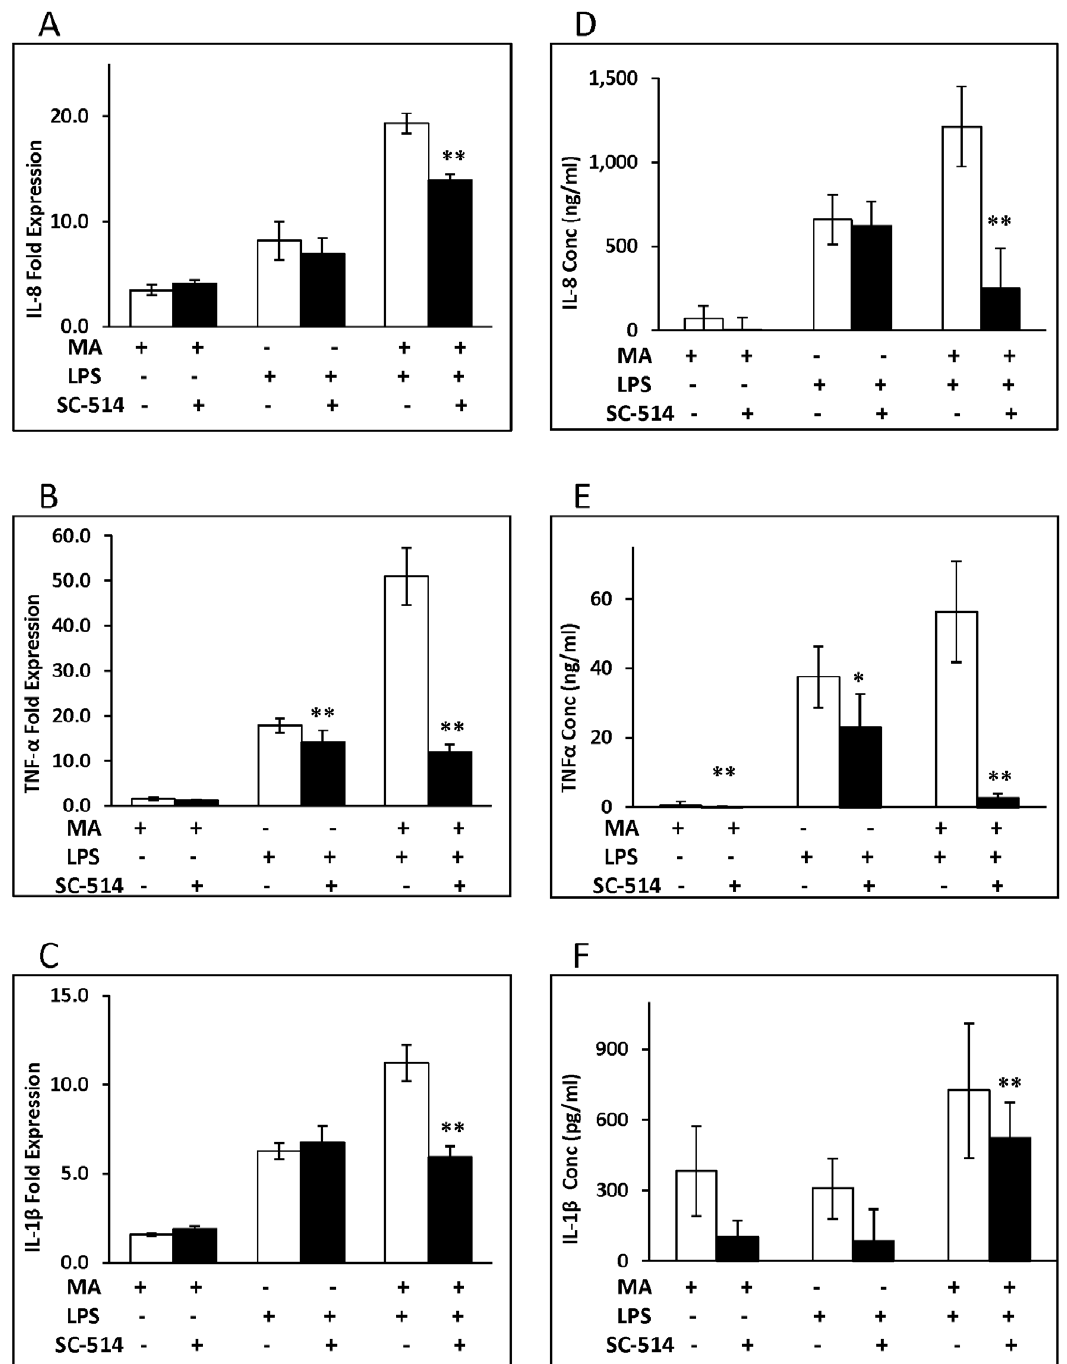
Figure 3. An inhibitor of NF-kB abrogates cytokine/chemokine expression induced by MA ± LPS. (A–C)1 6 10 6 U937 monocytes were differentiated into macrophages with 100 nM PMA for 48 h. IKK2 inhibitor SC-514 was added 1 h before each MA exposure at 0, 24, 48 h. Cells were treated with LPS and the final dose of MA and then harvested after 3 h for RNA isolation and real time RT-PCR analysis. The mRNA expression levels were compared to untreated control. (D–F) For cytokine protein levels, cell supernatants were harvested 24 h after the last MA 6 LPS treatment. The protein concentrations were normalized by subtracting values of control or inhibitor only. The means and SE values are from three independent experiments. *:p , 0.05; **: p , 0.01 comparing to MA/LPS/LPS + MA treatment as positive controls.